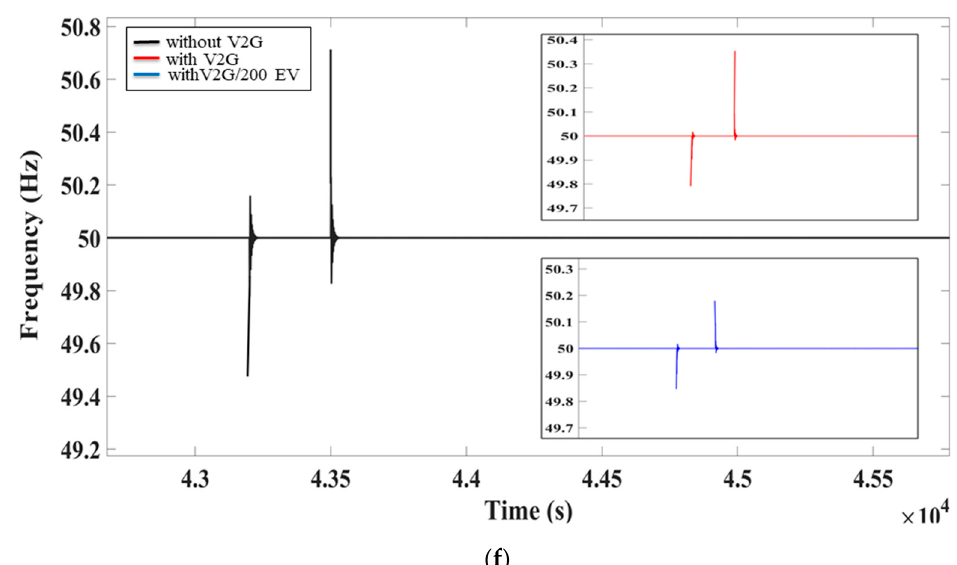
( f ) Figure 8. Tripping of wind farm: ( a ) wind profile, ( b ) wind apparent power, ( c ) SOC car profile for case 1, ( d ) SOC car profile 1 for case 2, ( e ) SOC car profile for case 3, and ( f ) frequency regulation for 3 different cases.